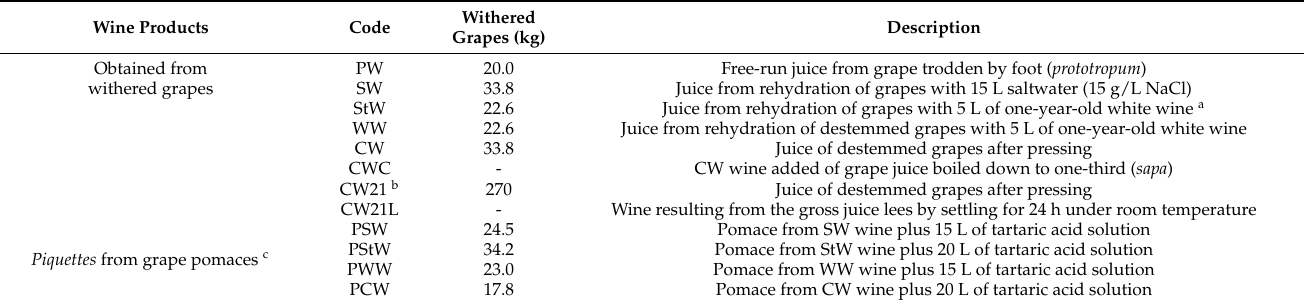
Table 1. Summarised description of the different grape processing modalities based on Columella [14] and Pliny [15].